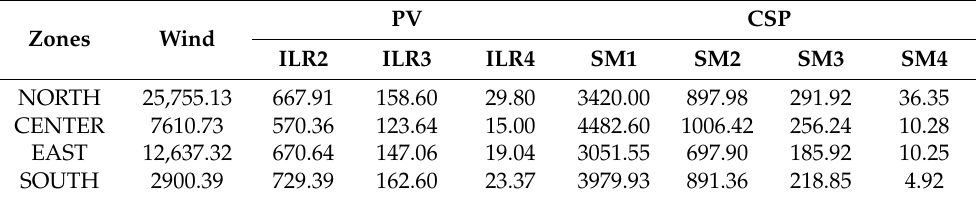
Table 8. Variance/Cost(yr/EeMW),